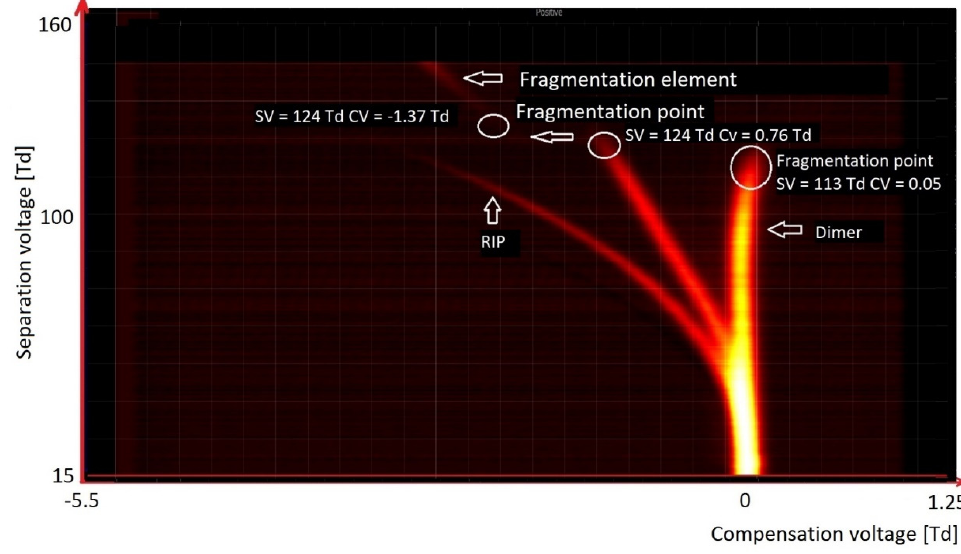
Figure 7. DMS spectrogram of ethyl acetate, with points indicating fragmentation.